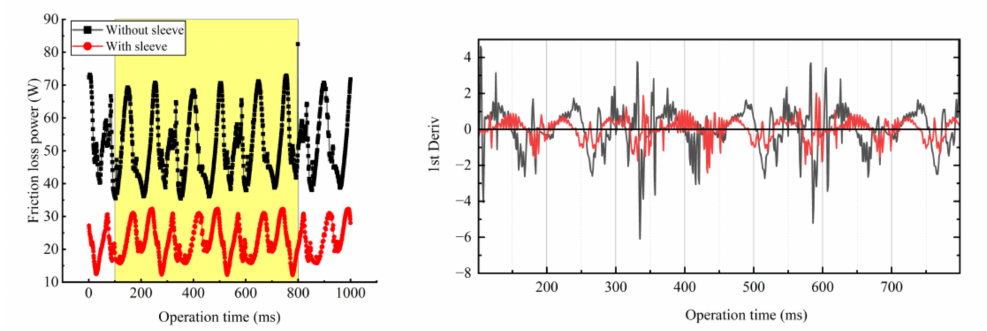
Figure 14. System power consumption within 1 s.